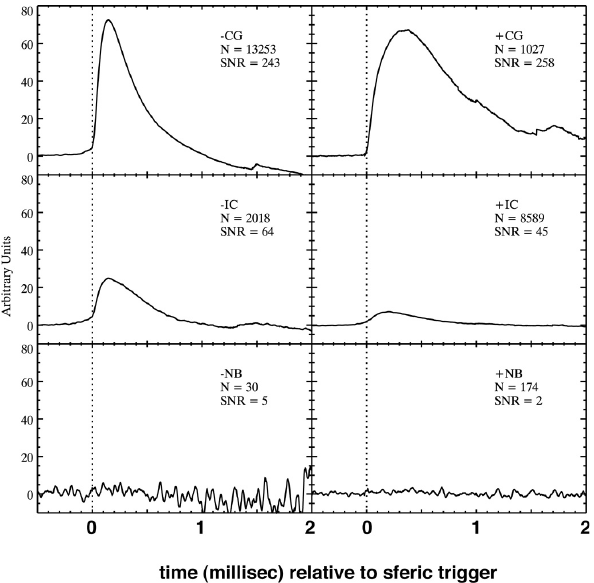
Fig. 13. Composite optical waveforms, constructed as described in the text.